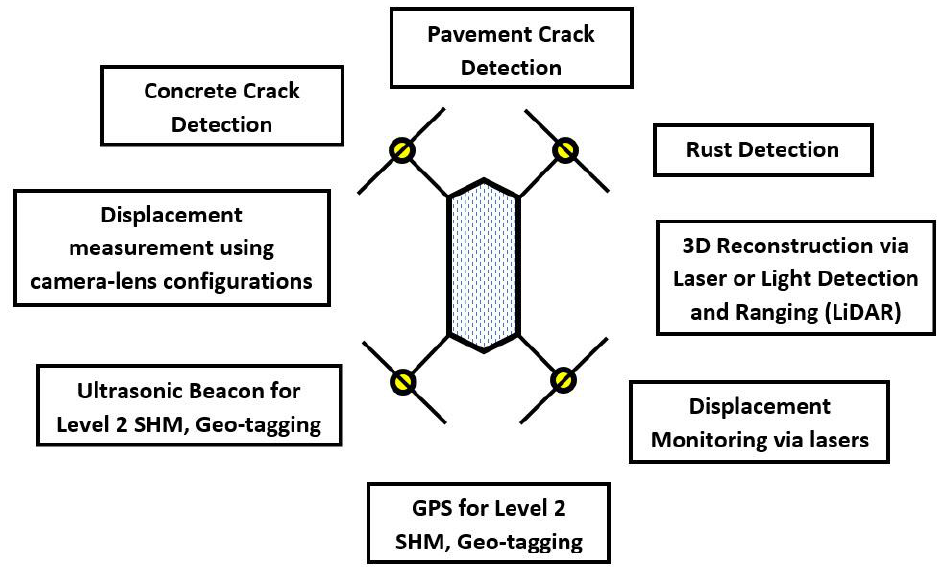
Figure 5. The varied applications of UAVs in the field of damage assessment in SHM systems.